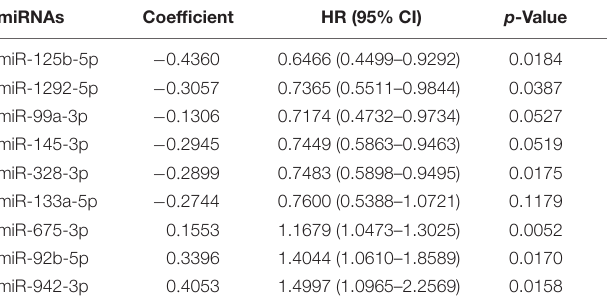
TABLE 2 | Results of multivariate Cox regression analysis of nine prognostic immune-related miRNAs in the